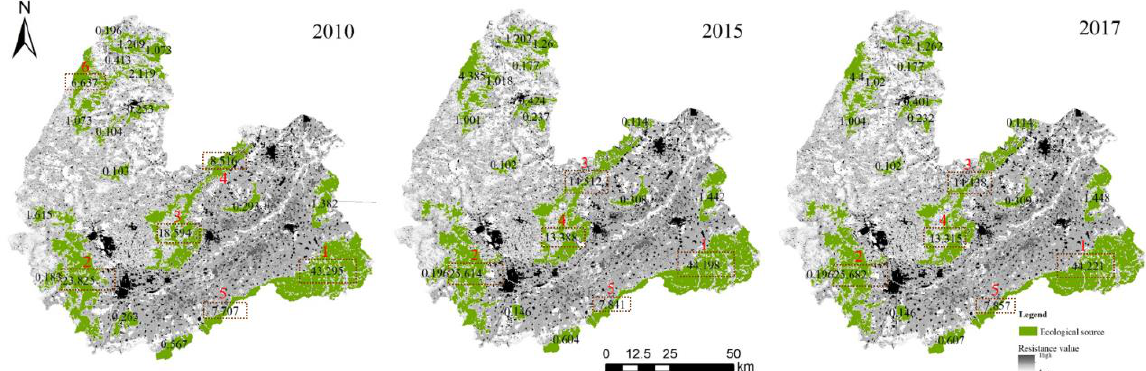
Figure 6. Ecological sources and resistance surface from 2010 to 2017. Black numbers as their dPC values represent the core patches’ importance, while the red number represents the dPC rank, and the dPC value is greater than 5.